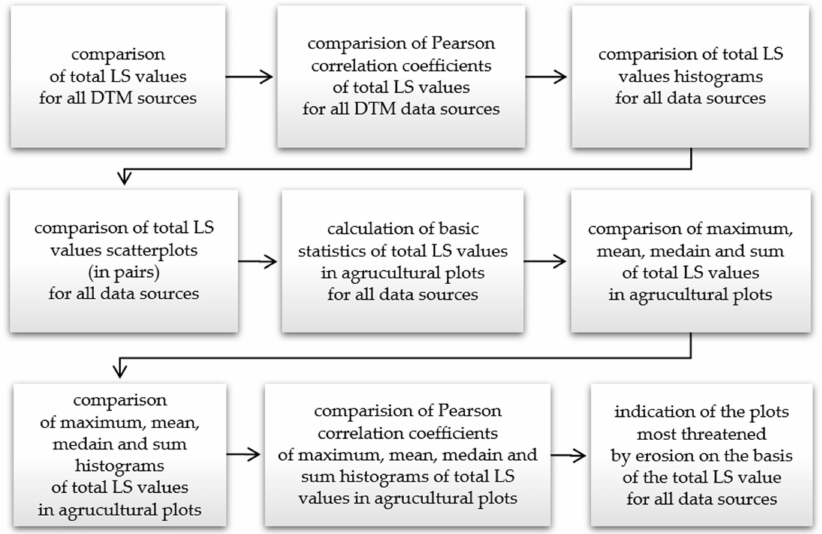
Figure 7. The methodology of the comparative analysis of the total LS factors value (stage